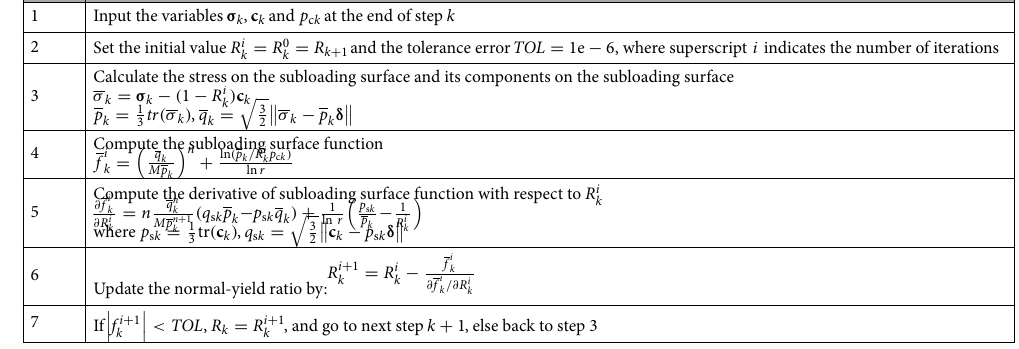
Table 1. The numerical calculation procedure of R by the Newton–Raphson